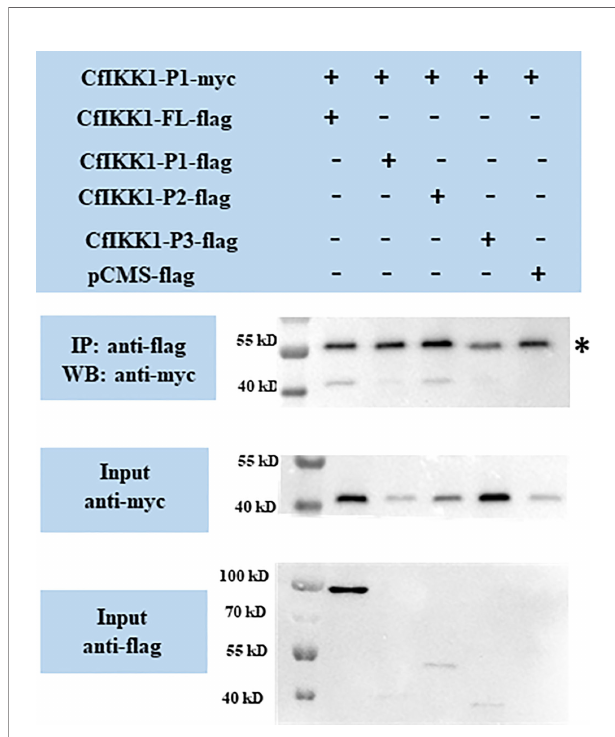
FIGURE 6 | Interaction between full-length CfIKK1 proteins (CfIKK1-FL-myc) and various CfIKK1- fl ag proteins (CfIKK1-FL, CfIKK1-P1, CfIKK1-P2, and CfIKK1-P3), as veri fi ed using co-immunoprecipitation assays. CfIKK1-FL-myc was detected in the anti- fl ag immunoprecipitates of co-transfected (CfIKK1- FL, CfIKK1-P1, CfIKK1-P2, and CfIKK1-P3) cell extracts, indicating the interaction of CfIKK1-FL-myc with CfIKK1-FL- fl ag, CfIKK1-P1- fl ag, CfIKK1- P2- fl ag, and CfIKK1-P3- fl ag. Asterisk represents the heavy chain of mouse IgG. IP, co-immunoprecipitation assay; WB, western blot assay.